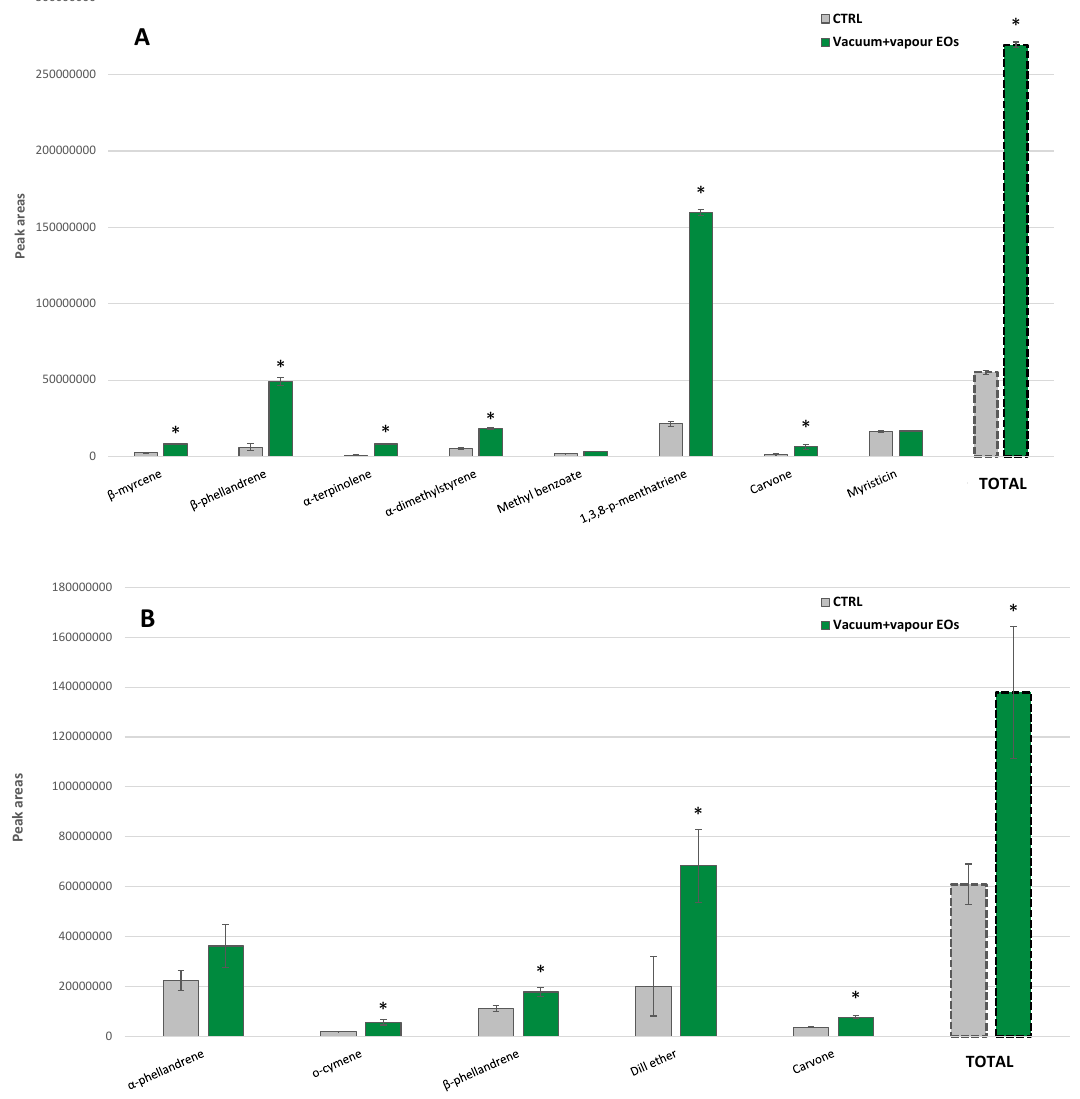
Figure 9. Volatile organic compounds profile of ( A ) curly parsley and ( B ) dill, untreated (CTRL) or after vacuum cooling and vapor essential oils (EOs) treatment, at the industrial scale (validation) (mean ± SD). * Significant differences among the EOs and CTRL samples are denoted by an asterisk at p < 0.05 according to an independent samples t-test.